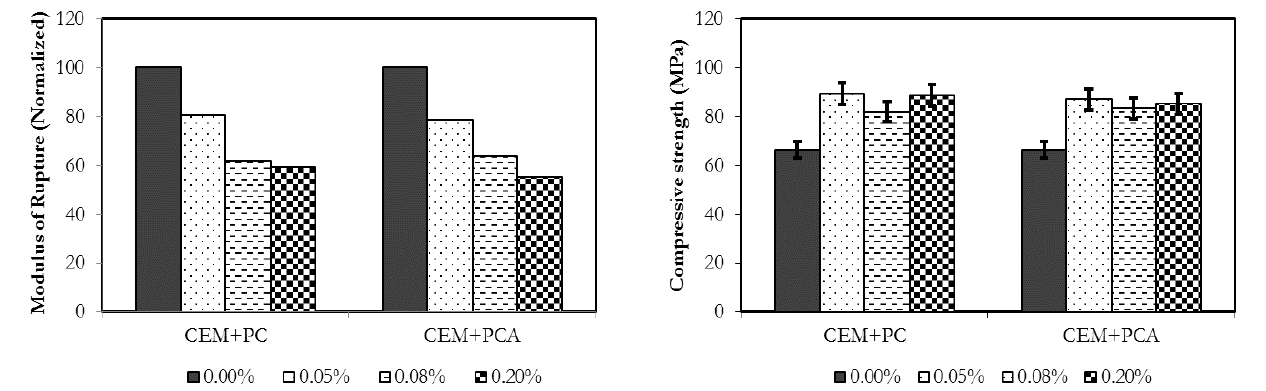
Figure 6: Modulus of rupture of cement composites with PC & PCA particles inclusions.